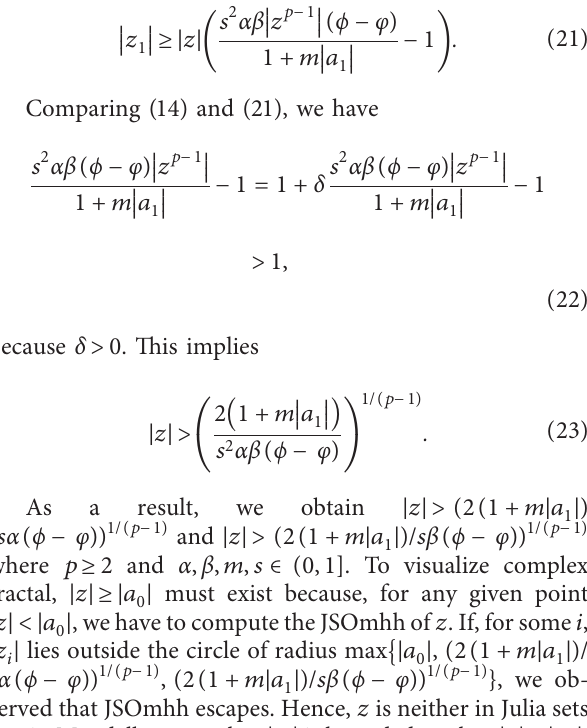
Figure 7: p � 3, a 50, a, b, s, m � 0 . 9, A � [− 0 . 01 , 0 . 01 ] × [− 0 . 01 , 0 . 01 ] . Figure 8: p � 3, a 50, a, b, s, m � 0 . 9, A � [− 0 . 012 , 0 . 01 ] × [− 0 . 012 , 0 . 01 ] . Figure 9: p � 3, a 50, a, b, s, m � 0 . 9, A � [− 0 . 00007 , 0 . 00007 ]× [− 0 . 00007 , 0 . 00007 ] . Figure 10: p � 3,, a � 0 . 9, A � [− 0 . 00009 , 0 . 00009 ] × [− 0 . 00004 , 0 . 00004 ] . Figure 11: p � 3, a a � 3, a � 0 . 1 , b � 0 . 9 , s, m � 0 . 5, A � [− 0 . 8 , 0 . 6 ]× 3 [− 0 . 6 , 0 . 7 ] . Figure 12: p � 3, a a � 3, a � 0 . 1 , b � 0 . 9 , s, m � 0 . 5, A � [− 0 . 8 , 0 . 6 ]× 3 [− 0 . 6 , 0 . 7 ] .